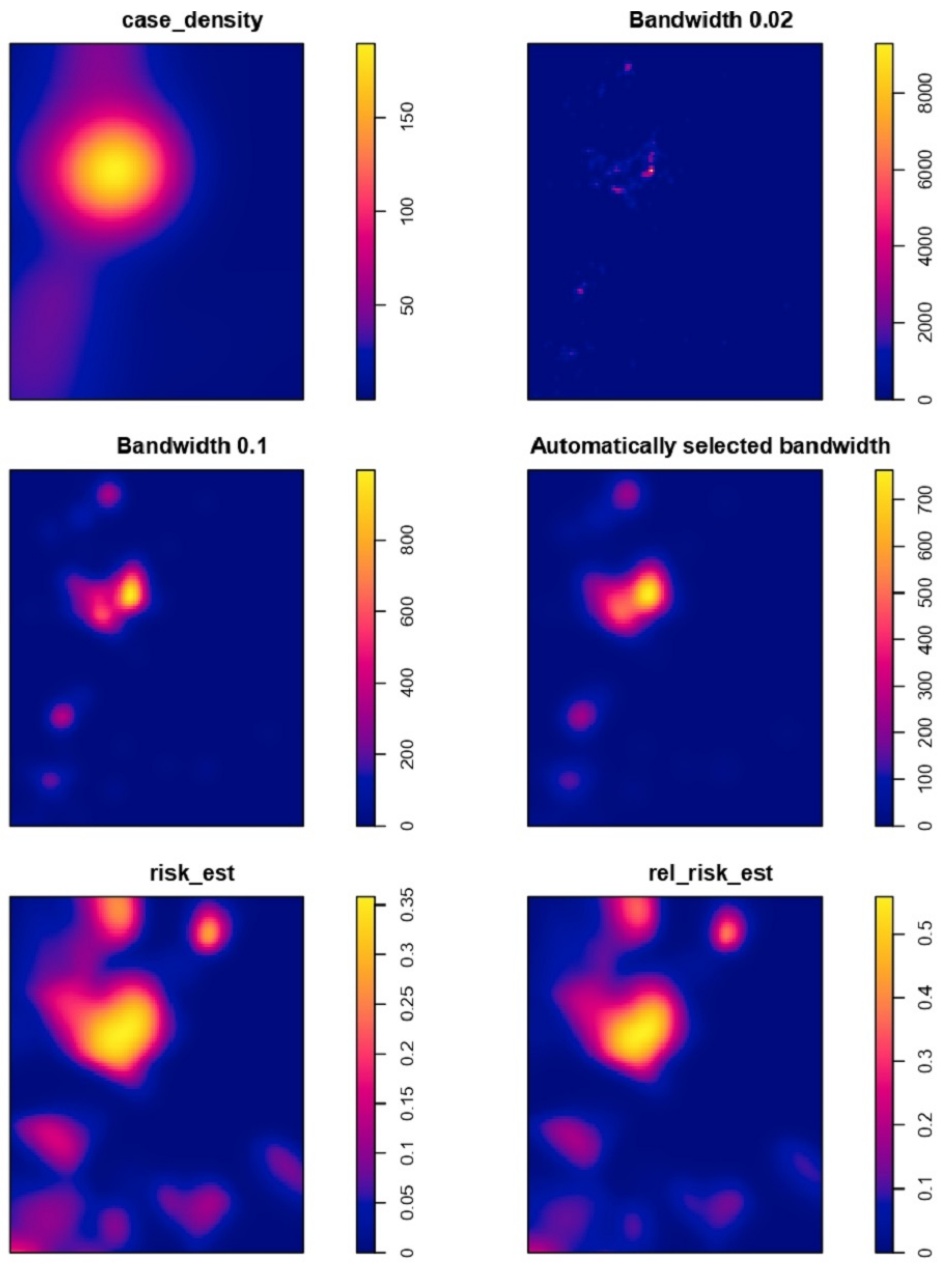
Figure 2. Kernel density plots displaying the density of case farms ( top left ) by kernel density estimation based on multiple bandwidths of 0.02 ( top right ), 0.1 ( middle left ), and automated bandwidth selection by cross validation ( middle right ). Risk estimate ( bottom left ) and relative risk estimate ( bottom right ) with colored scale bar on the right denoting intensity of risk from blue to yellow, with a relative unit of measurement used to represent the proportion of risk value.